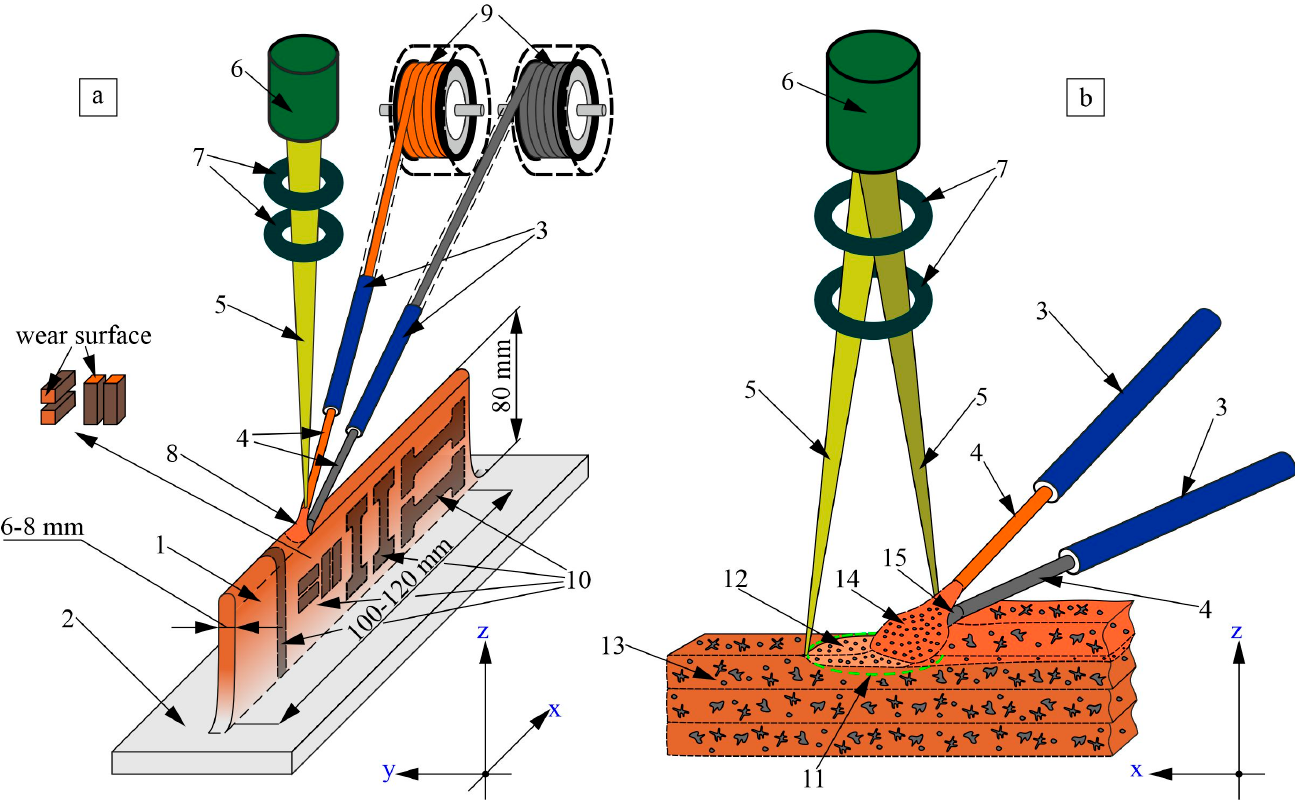
Figure 1. Scheme of sample printing by double-wire electron beam additive manufacturing. ( a ) - scheme of sample printing and cutting out samples for research; ( b ) - schematic representation of composite material formation.